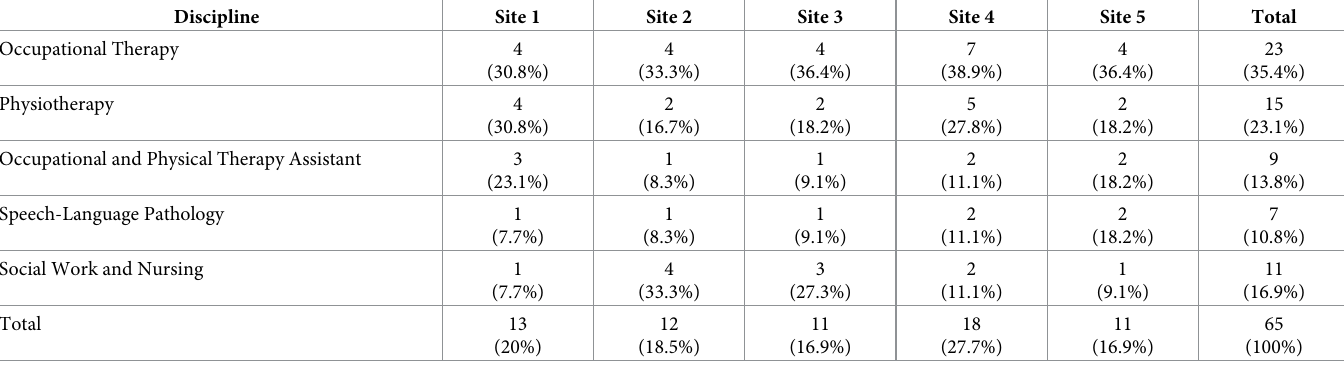
Table 3. Participants who enrolled in CO-OP